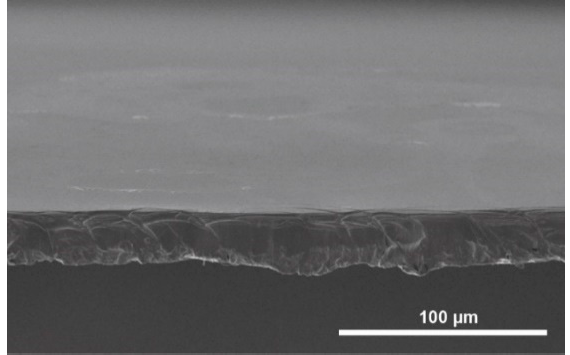
Figure 4. Scanning electron microscopy was applied to analyze the morphology of silk fibroin film cast from silk fibroin dissolved in ZnCl 2 and desalted by gel filtration.